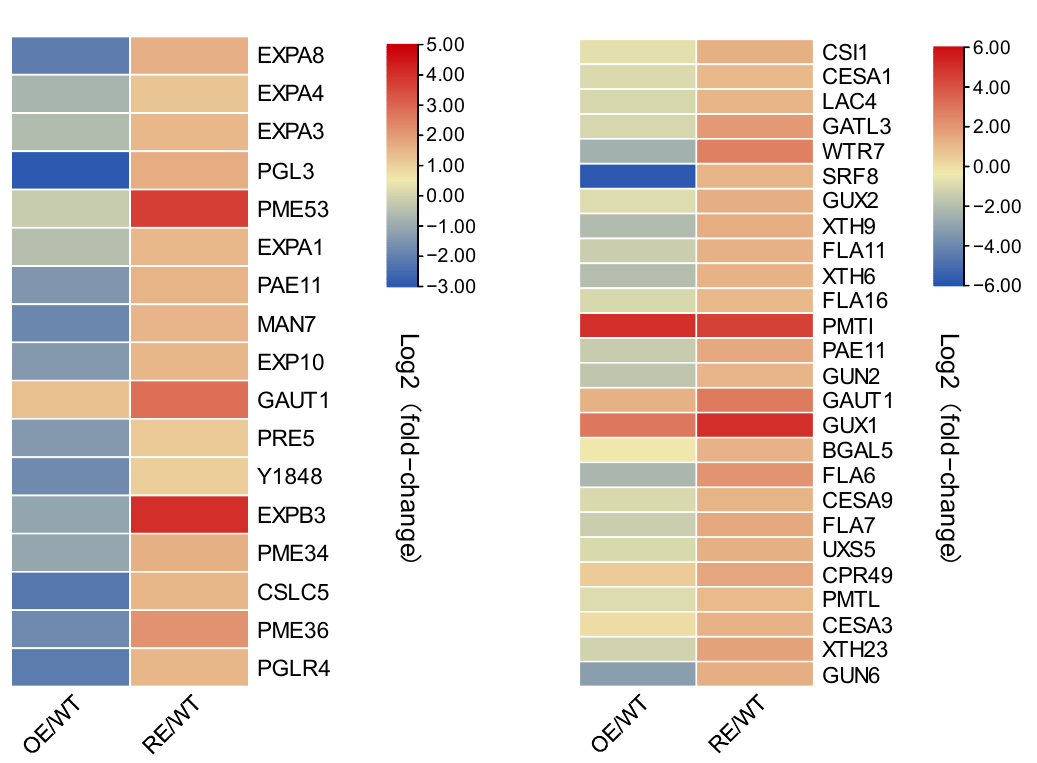
Figure 8. A GO enrichment analysis of DEGs in PsnWRKY70 transgenic poplar. ( A ) A GO enrich- ment analysis of uniquely upregulated genes in OE lines. ( B ) A GO enrichment analysis of uniquely downregulated genes in OE lines. ( C ) A GO enrichment analysis of uniquely upregulated genes in RE lines. ( D ) A GO enrichment analysis of uniquely downregulated genes in RE lines.